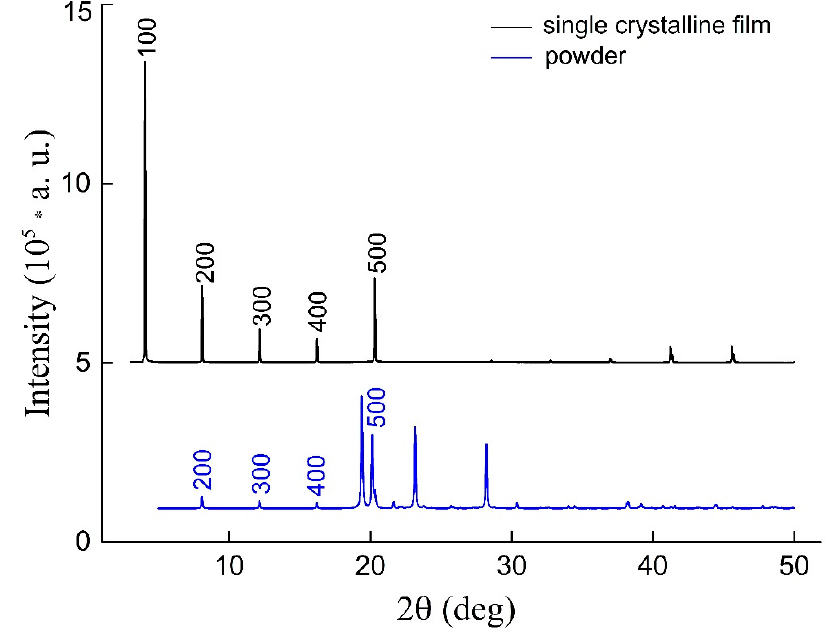
Figure 6. Diffraction patterns of a p-quinquephenyl vapor-grown single-crystalline film (black line) and crystalline powder (blue line).